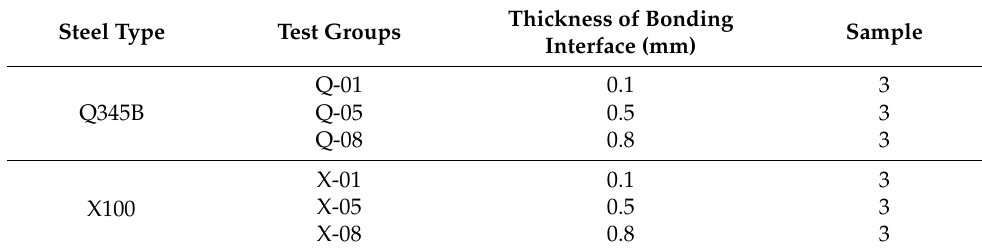
Table 2. Test Configuration and Specimen Groups.